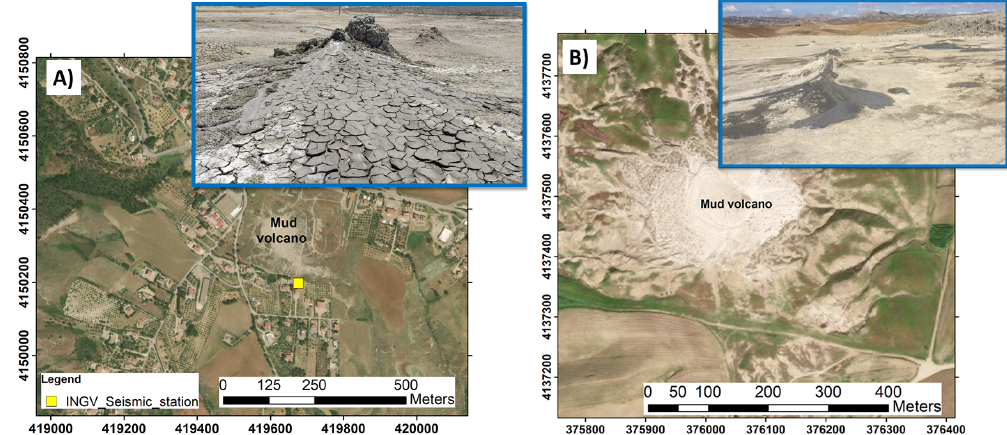
Figure 2. Location of the two mud volcano areas: Santa Barbara (A) and Aragona (B) . Image of ArcGis 10.5,